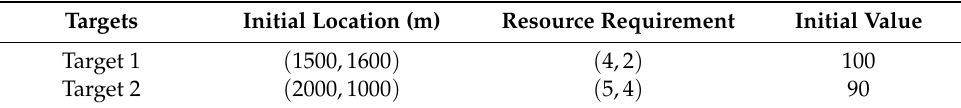
Table 1. The initial information of the targets.